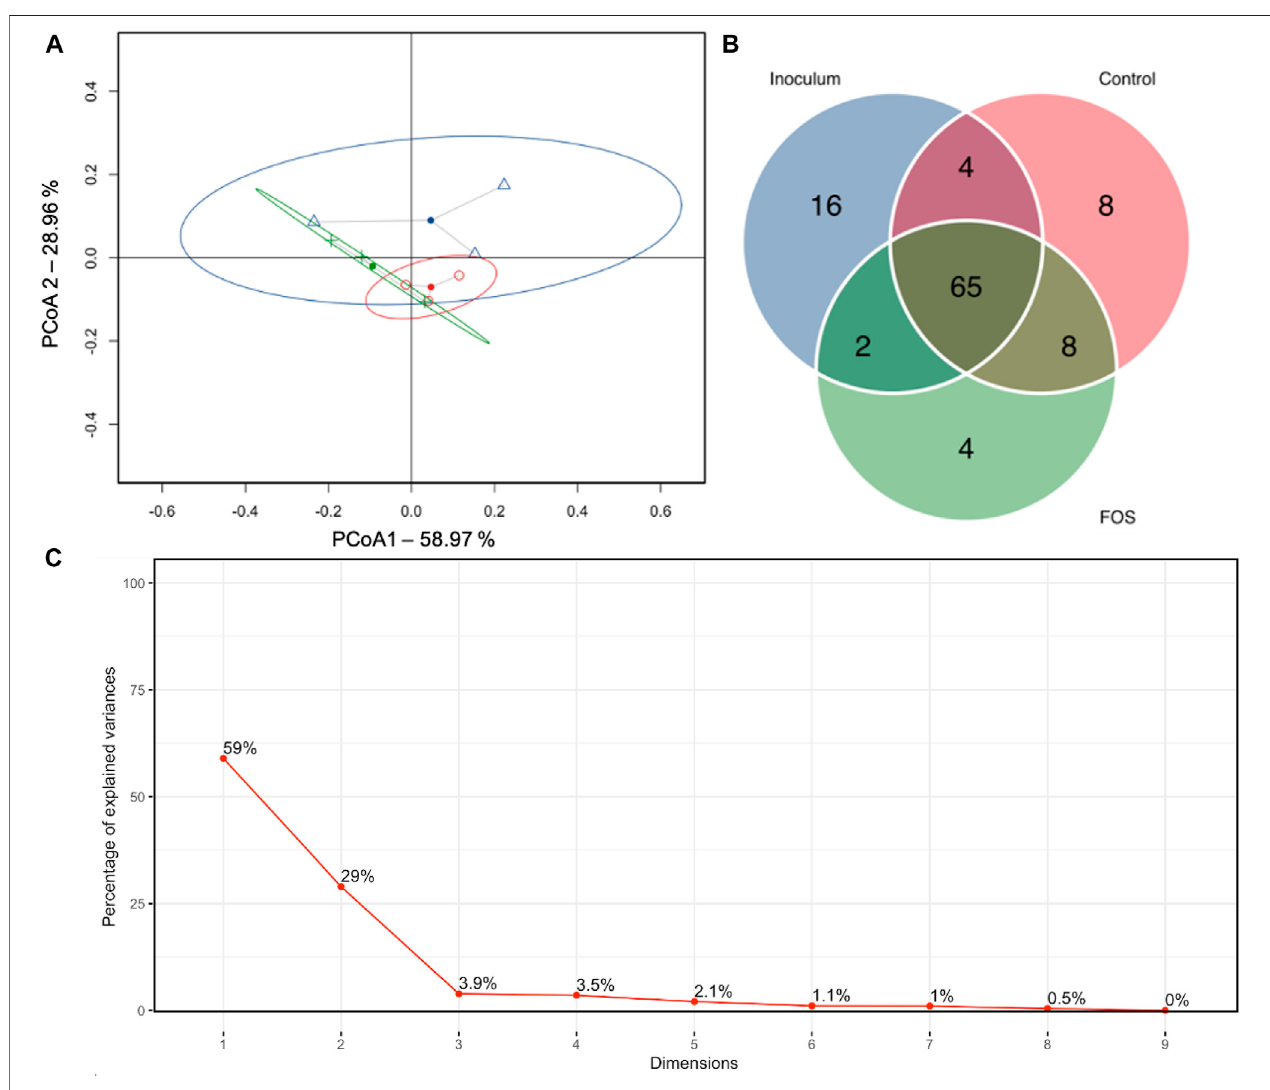
FIGURE2|(A) PrincipalcoordinateanalysisderivedfromweightedUniFracdistanceamongsamplesoftreatments(inoculum,blue;control,red;andconcentration of Lv 150 mg/L, green). (B) Venn diagram analysis among three treatments. (C) The percentage of variation explained by each PCoA